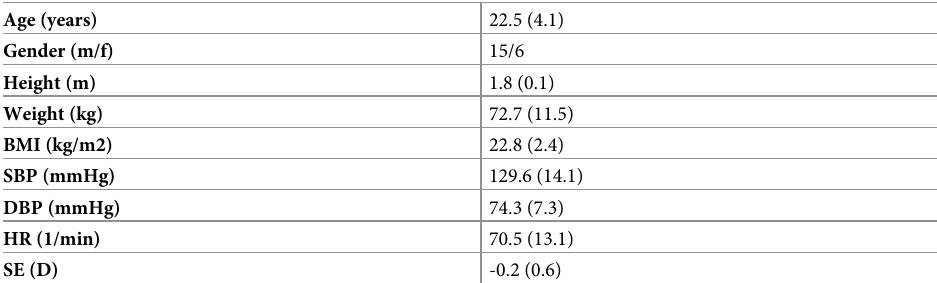
Table 1. Descriptive statistics of the study